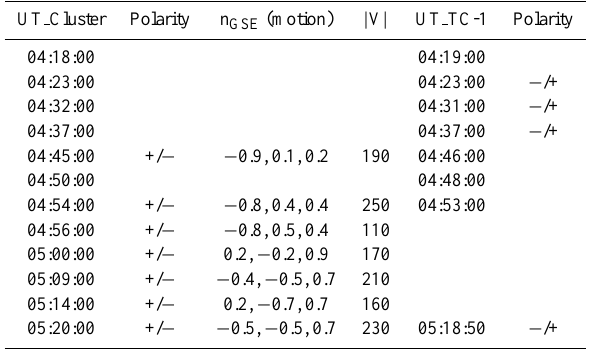
Table 1. Catalogue of Cluster FTE motions for the FTEs marked on Fig. 3. The normal, n, is obtained directly from timing analysis and represents the direction of the velocity, V. Polarities are marked for each spacecraft. These were not clearly resolved for four of the TC-1